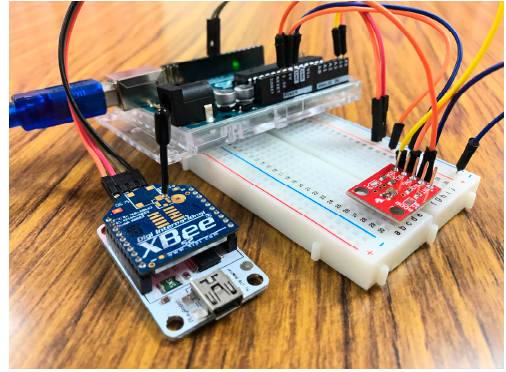
Figure 17. The mobile luminosity-monitoring device.